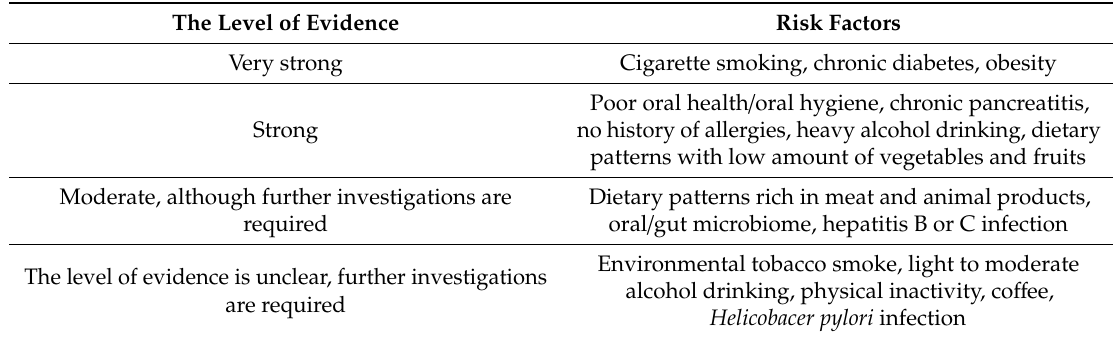
Table 1. Environmental (non-genetic, including lifestyle, and clinical factors) risk factors of pancreatic cancer by the level of